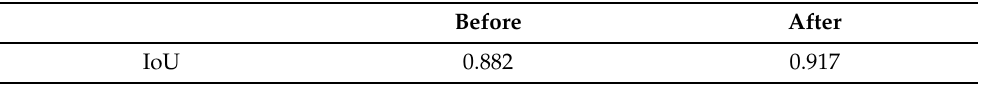
Table 1. IoUs for Data_Pears1 before and after the fine-tuning with Data_Pears2 .